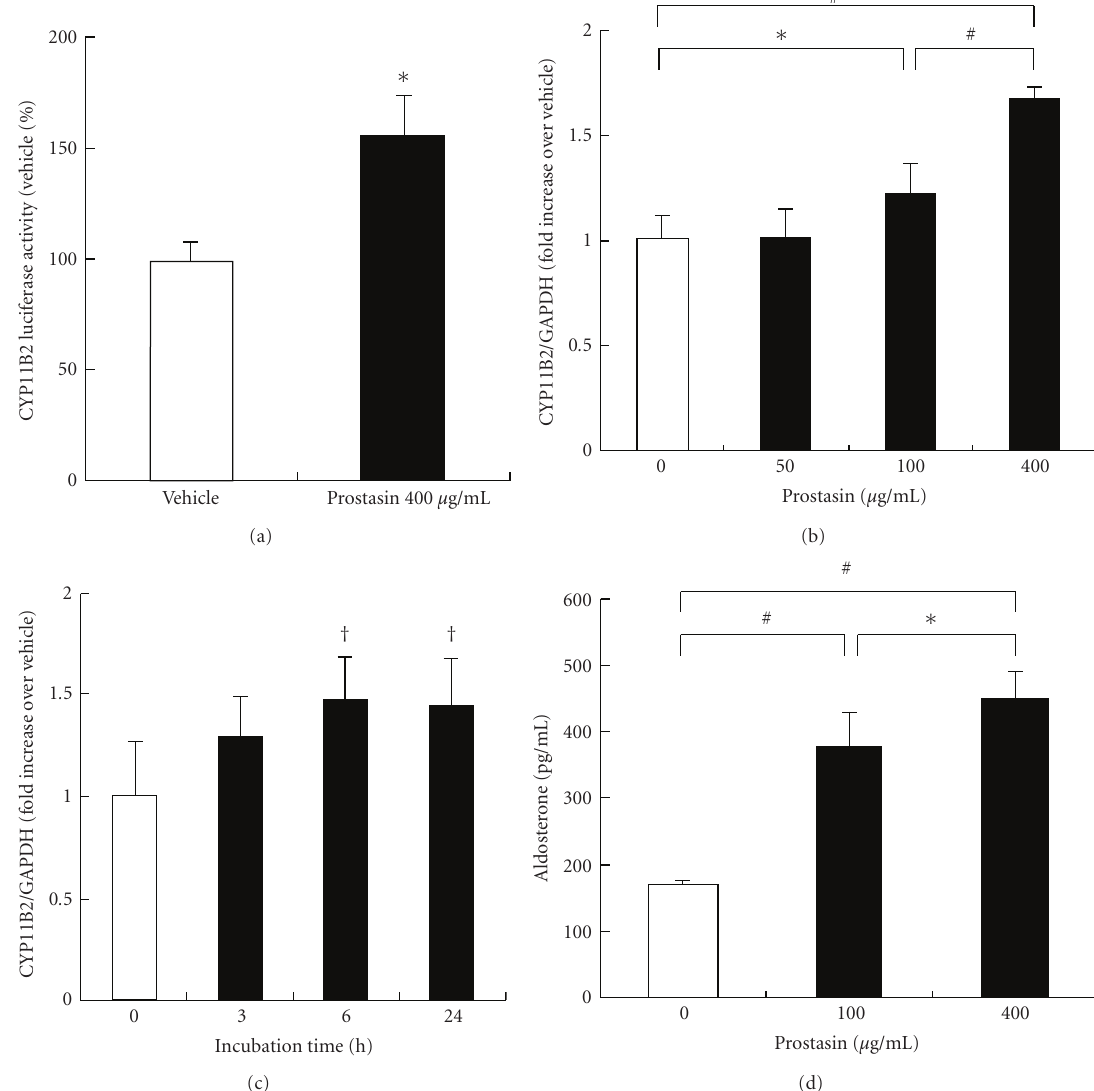
Figure 1: (a) E ff ect of prostasin on human CYP11B2 promoter activity in H295R cells. Cells were transfected with human CYP11B2 promoter-luciferase construct (pB2-1521) for 24 hours and then treated with vehicle or prostasin for another 24 hours. (b) Dose-dependent e ff ect of prostasin on CYP11B2 mRNA expression in H295R cells. Cells were treated with increasing doses of prostasin for 24 hours. (c) Time course of CYP11B2 mRNA induction by prostasin in H295R cells. Cells were treated with 100 ¯g/mL of prostasin for 0, 3, 6, and 24 hours. (d) Dose-dependent e ff ect of prostasin on aldosterone production in H295R cells. Cells were treated with increasing concentrations of prostasin for 48 hours. Values are means ± SD ( n = 6). ∗ P < . 05, † P < . 01, and # P < .